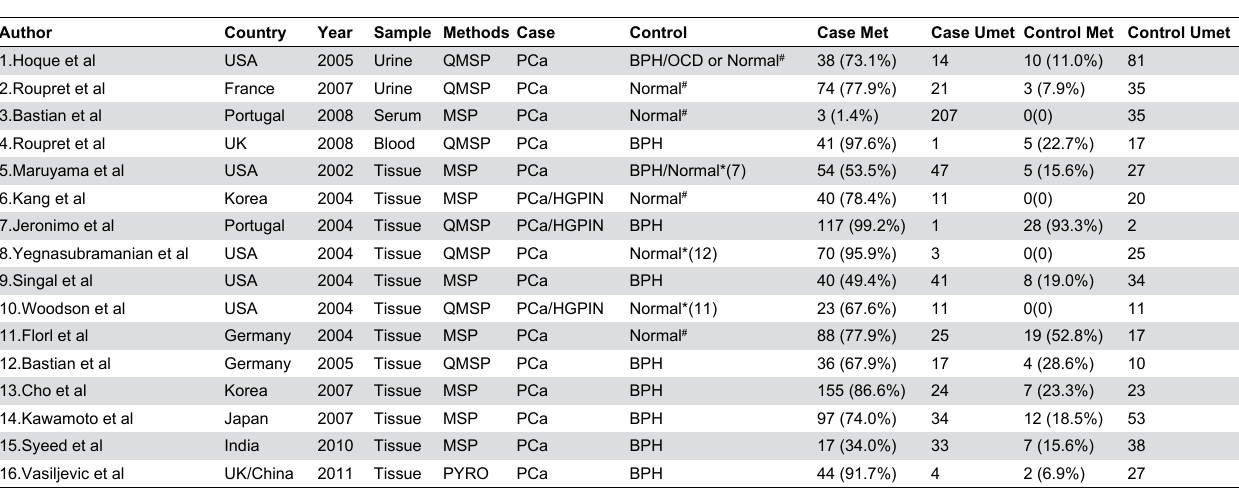
Table 1. Characteristics of studies included in the